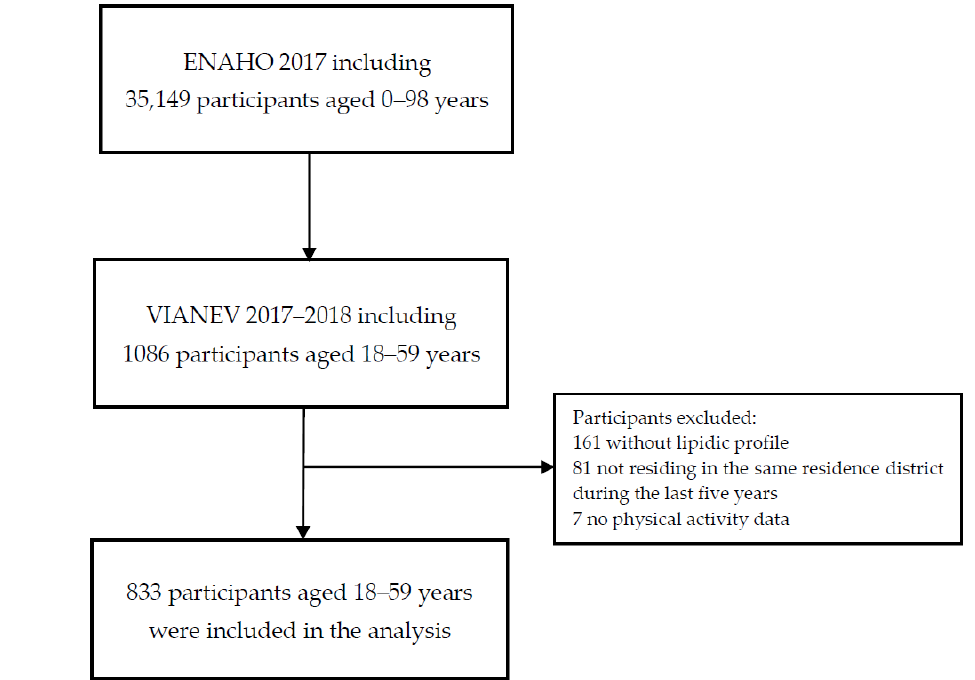
Figure 1. Flow chart of participants included in the study analysis.